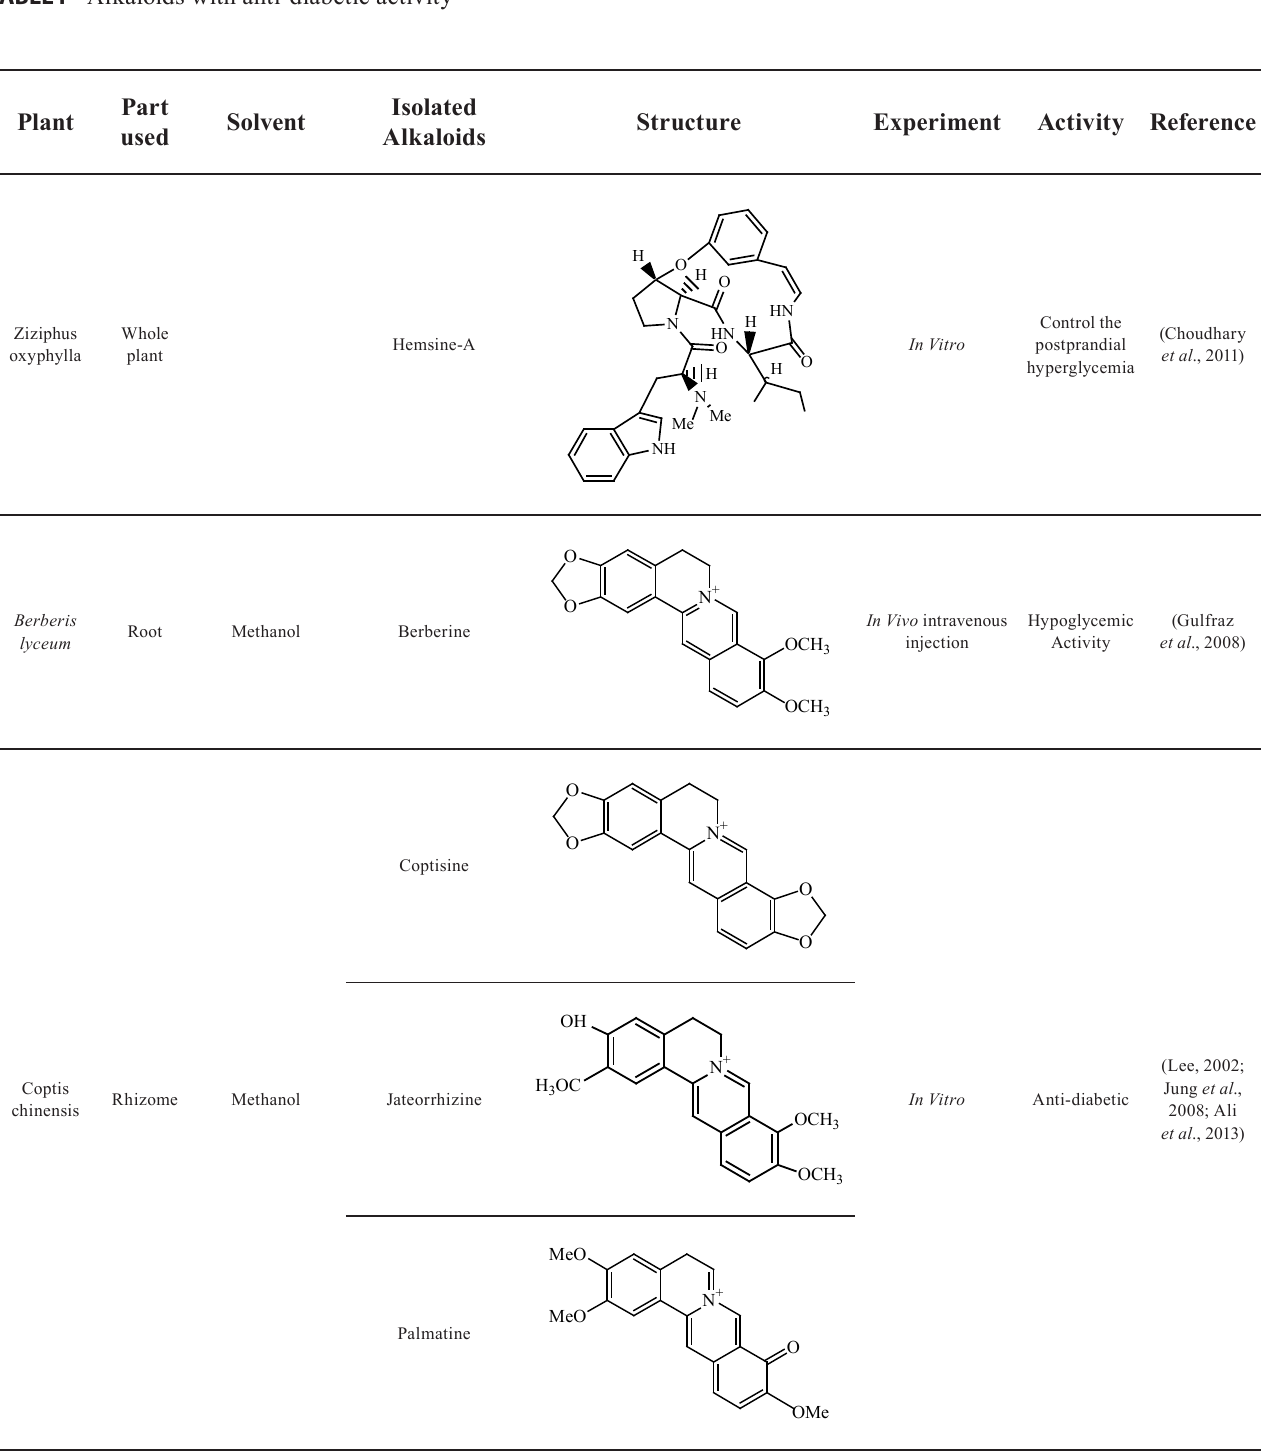
TABLE I – A lkaloids with anti-diabetic activity